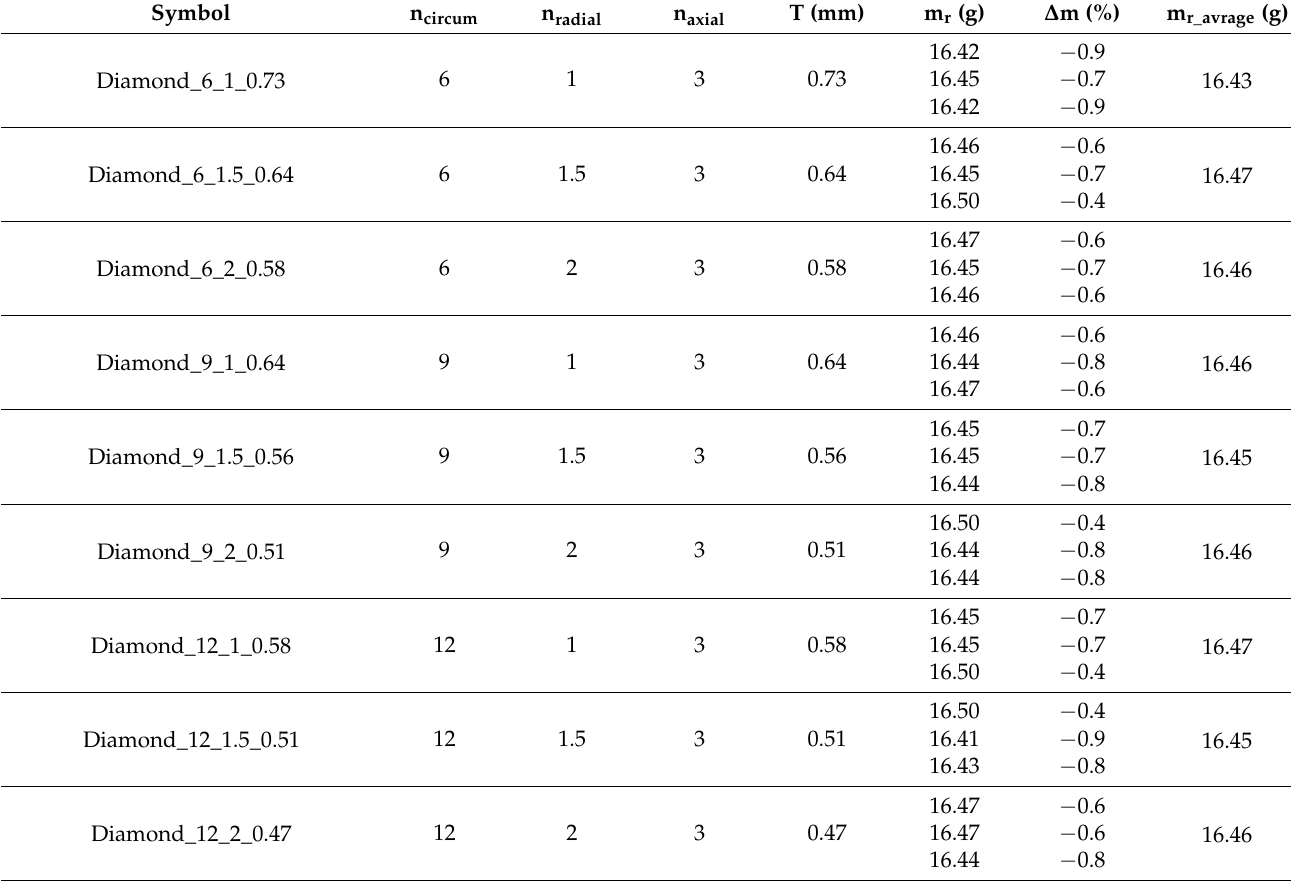
Table 3. Parameters of sample structures